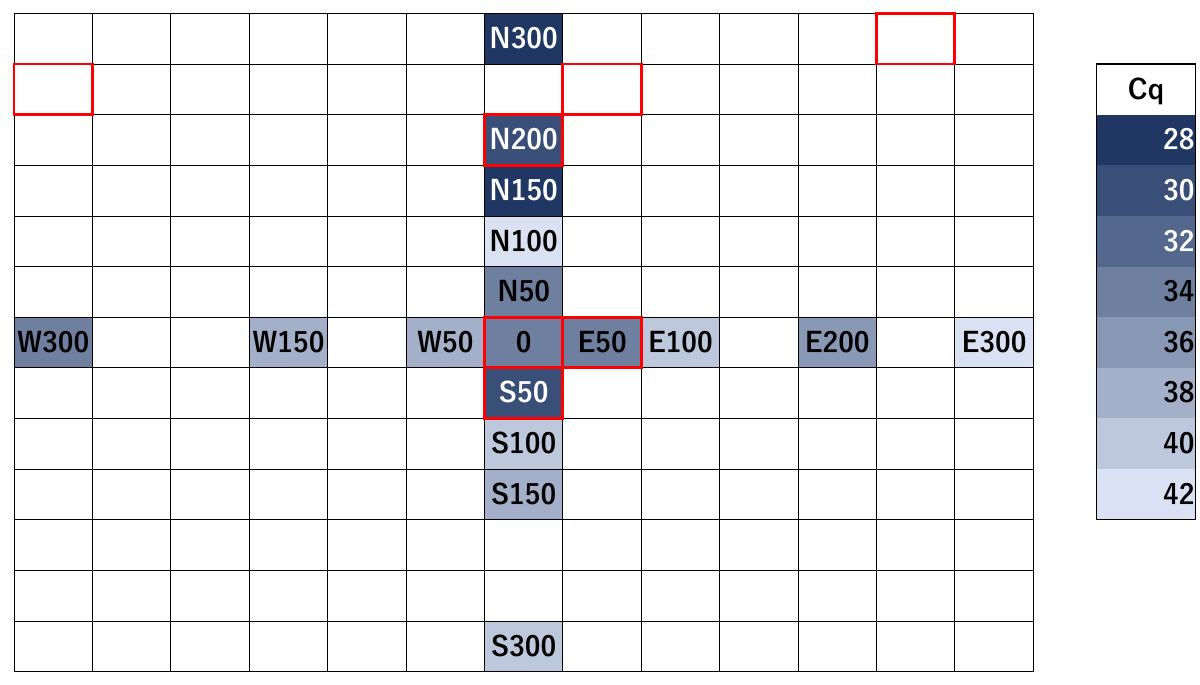
Figure 3. Comparison of Cq values obtained by real-time PCR of Port Island samples in November 2018. The cells were colored based on the Cq value of each sample. The darker blue indicates lower Cq value, indicating more DNA. Red frames indicate areas where L. humile individuals or nests were found. Samples of S200, E150, W100, and W200 were excluded because DNA could not be extracted successfully (see text for